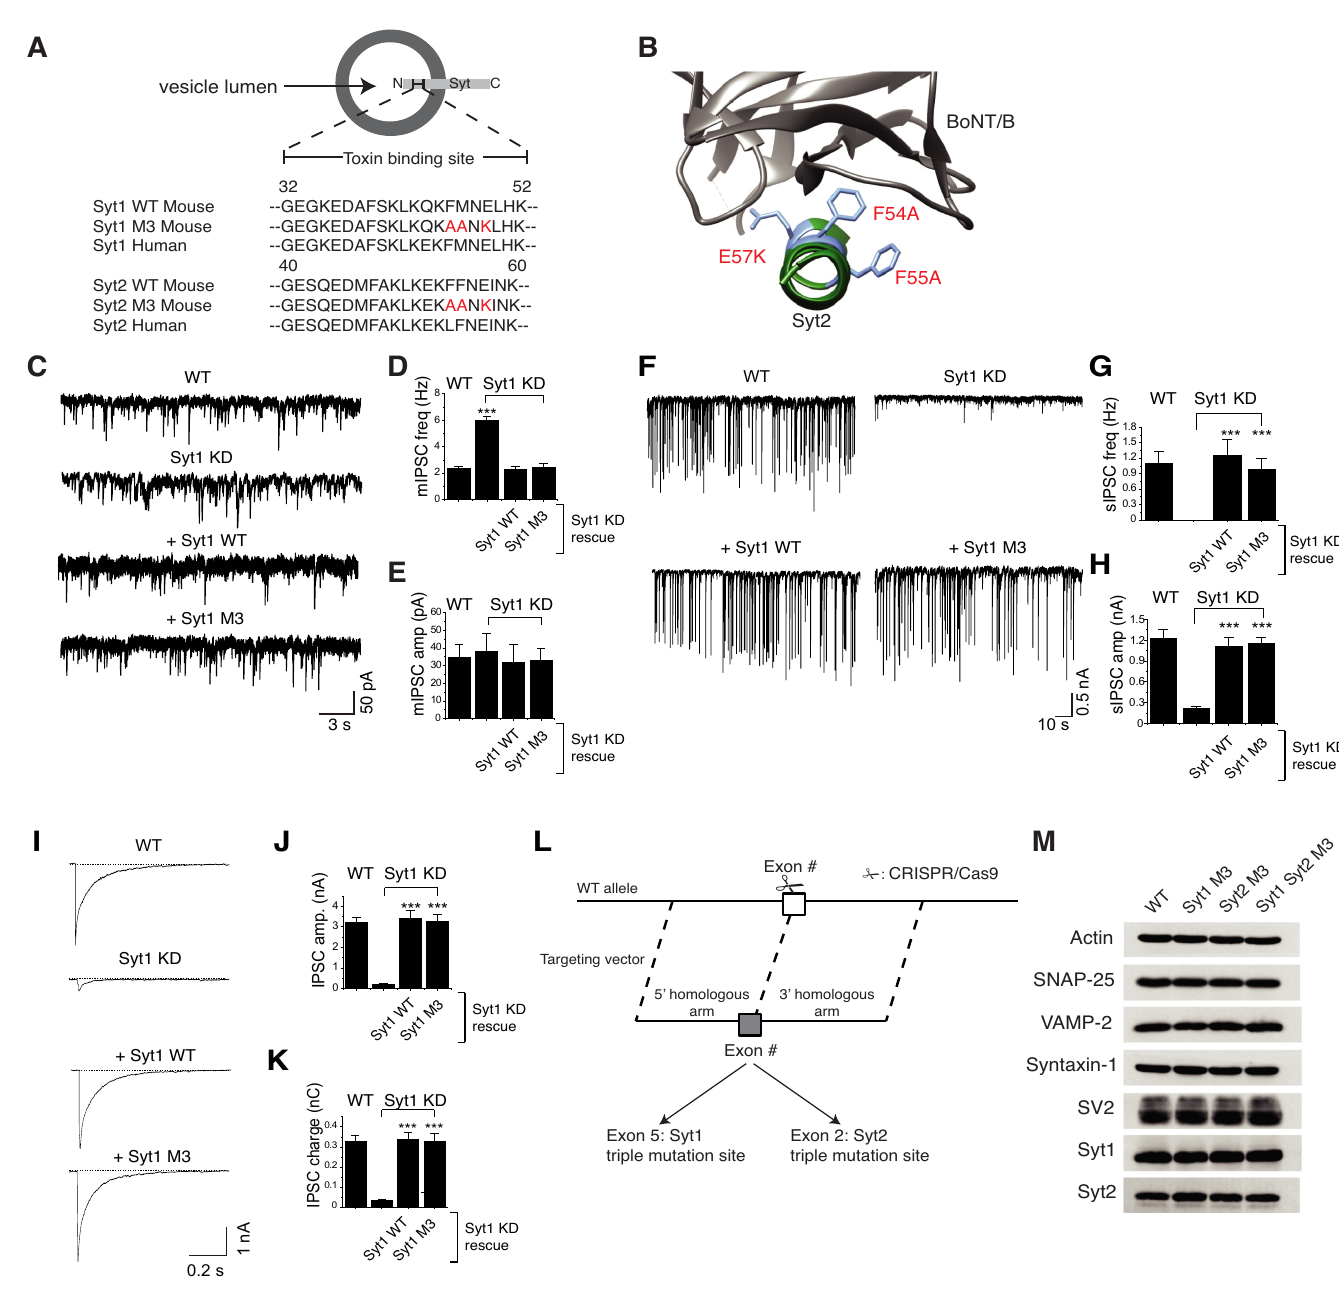
Fig 1. Characterizing triple point-mutations and generation of Syt1 M3 and Syt2 M3 KI mice. A. Sequence alignment of the BoNT-binding region in Syt1 and Syt2 (residues 32 to 52 in Syt1 and 40 to 60 in Syt2). Residues highlighted in red mark the designed triple mutations (Syt1 M3 and Syt2 M3 ) that abolish BoNT-binding. B. Co- crystal structure of the BoNT/B-Syt2 complex (PDB:4KBB) with the triple mutation sites (F54A, F55A, E57K) highlighted. C-E. Miniature inhibitory postsynaptic currents (mIPSC) were monitored and analyzed by whole-cell patch-clamp recording in cultured rat cortical neurons, with representative traces shown in C, frequency (freq) in D, and amplitude (amp) in E. WT: wild type neurons; Syt1 KD: neurons with their endogenous Syt1 knocked down by shRNA expressed via lentiviral transduction; Syt1 WT : WT Syt1 is expressed in Syt1 KD neurons via lentiviral transduction; Syt1 M3 : Syt1 M3 mutant was expressed in Syt1 KD neurons via lentiviral transduction. Syt1 KD increased mIPSC frequency, which is restored by expression of either Syt1 WT or Syt1 M3 . For each condition, we recorded from 12–15 neurons from a total of four coverslips. Data shown are means ± SEM. Statistical analysis was performed with Student’s t-test ( ��� P < 0.001). F-H. Spontaneous inhibitory postsynaptic currents (sIPSC) were monitored and analyzed by whole-cell patch-clamp recording in cultured rat cortical neurons, with representative traces shown in F, frequency in G, and amplitude in H. The amplitude and frequency of sIPSC were greatly deceased in Syt1 KD, and both Syt1 WT and Syt1 M3 restored normal levels of